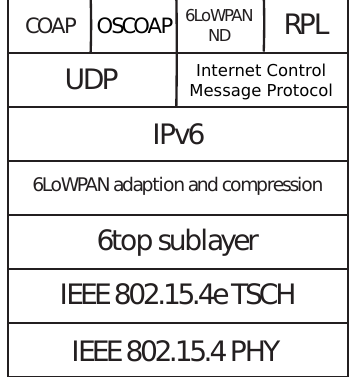
Figure 2. The IPv6 over the TSCH mode of IEEE 802.15.4e (6TiSCH) architecture stack. RPL, Routing Protocol for Low-power and Lossy